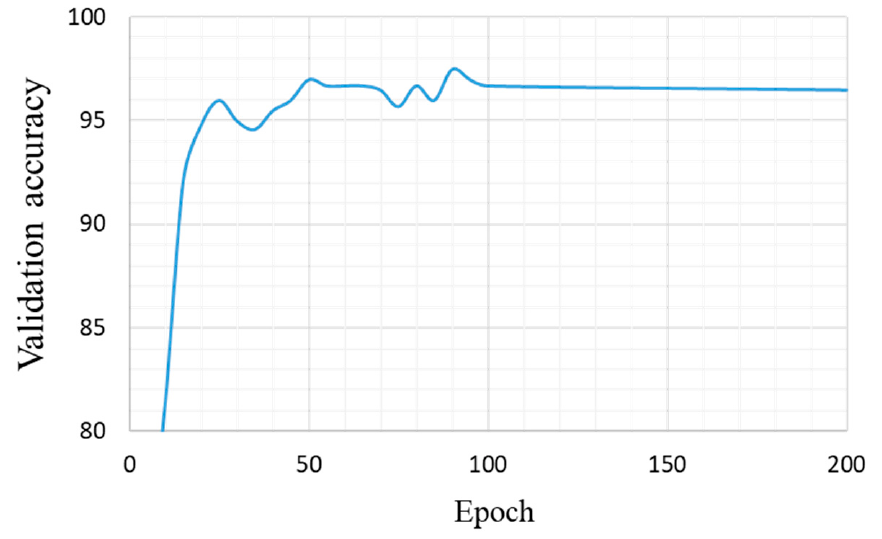
Figure 16. Validation accuracy per epoch. Table 8. Confusion matrix of the color identification using testing samples.